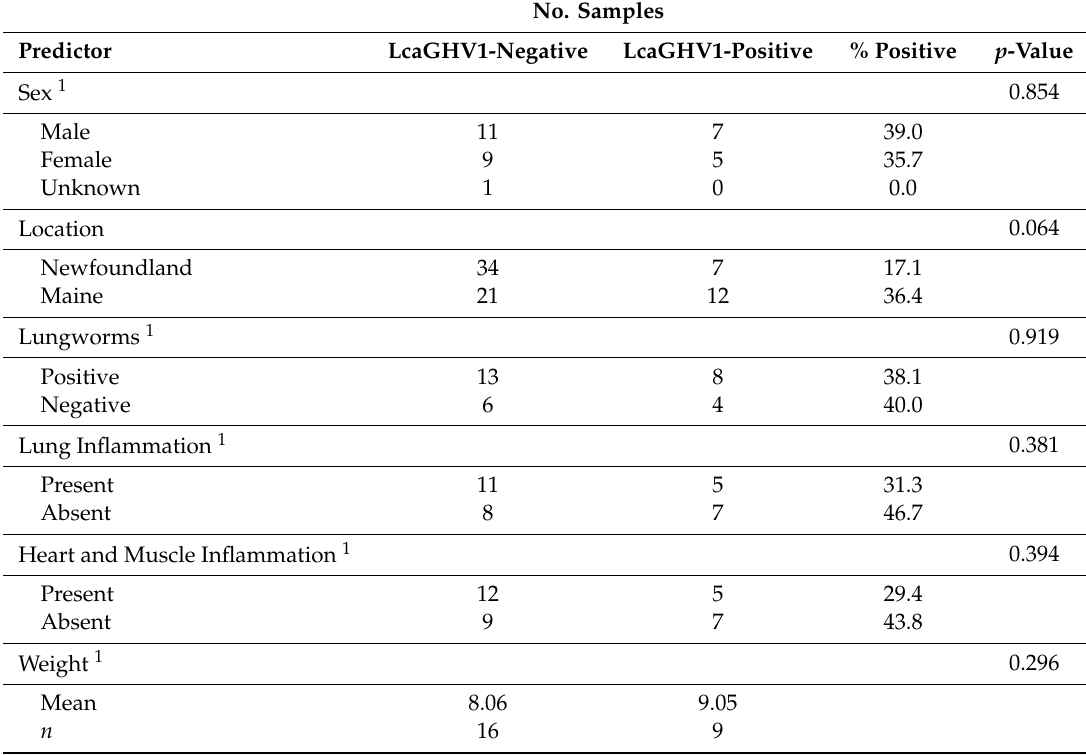
Table 3. Potential risk factors for LcaGHV1 infection status in